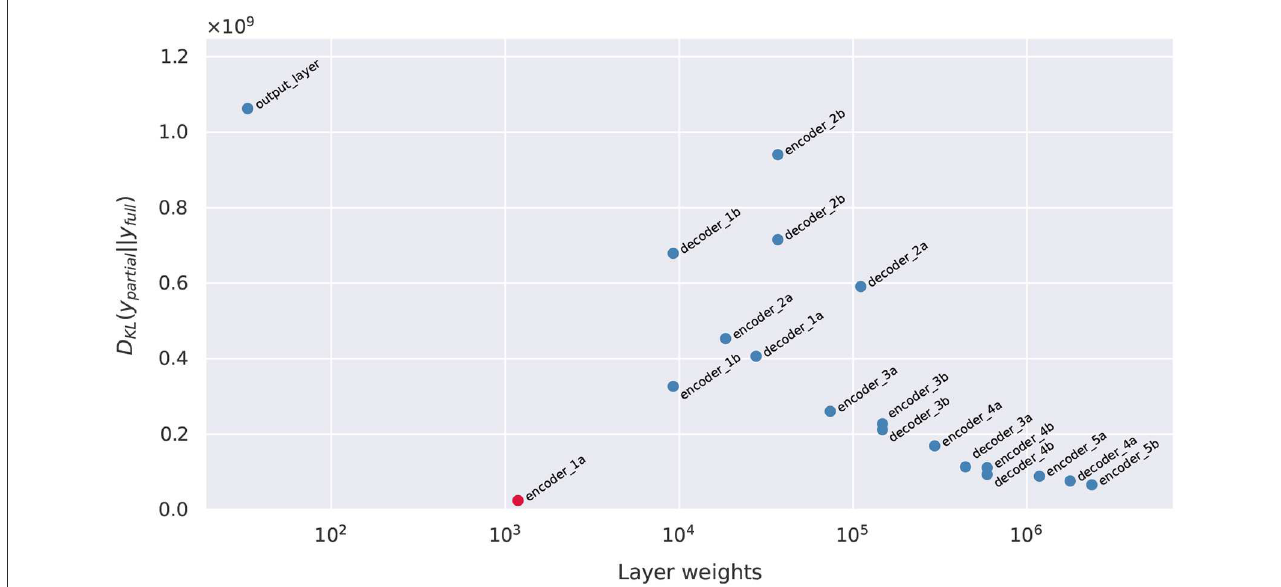
FIGURE9 Scatter plot of KL divergence sum vs. number of parameters in the Bayesian layer.